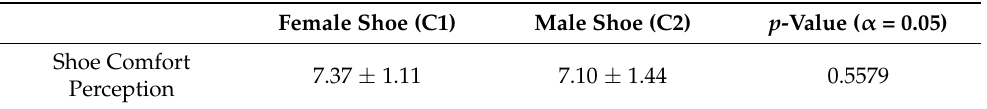
Table 3. Comparison of shoe comfort perception between shoe conditions. Data are presented as mean ± standard deviation with their associated p -values from the paired t -test ( α =